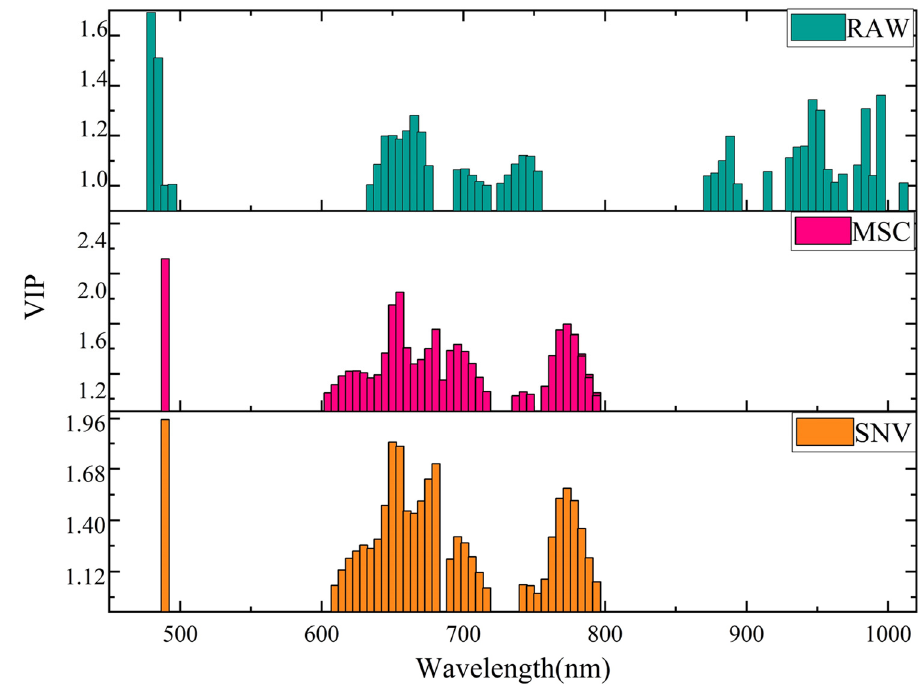
Figure 3. The distributions of all variables in each wavelength after the selection of VIP.